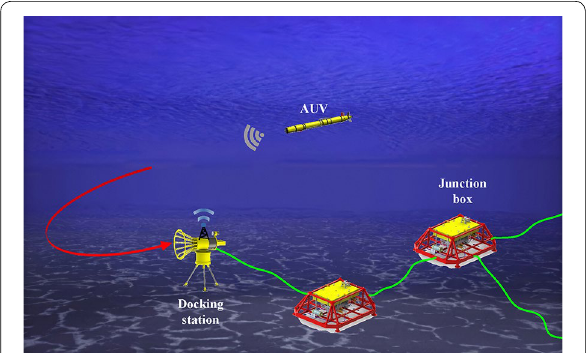
Figure 8 Combination of AUVs and docking